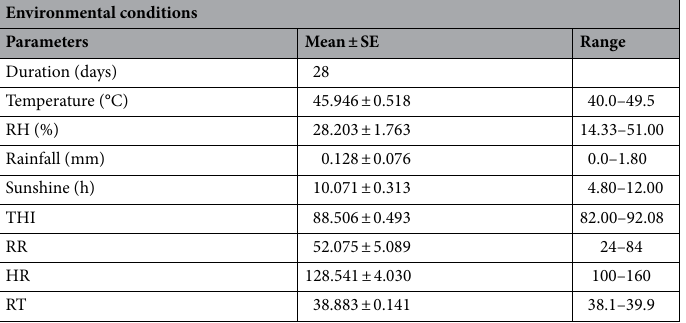
Table 1. Mean environmental conditions and physiological responses (RT, RR and HR) during heat stress period. RH Relative humidity in percentage; THI Temperature-humidity index; °C Degree centigrade; % Percentage; RR Respiration rate (breaths/min); HR Heart Rate (beats/min); RT Rectal temperature in degree centigrade (°C); SE Standard Error of mean; mm millimeters; h hours.